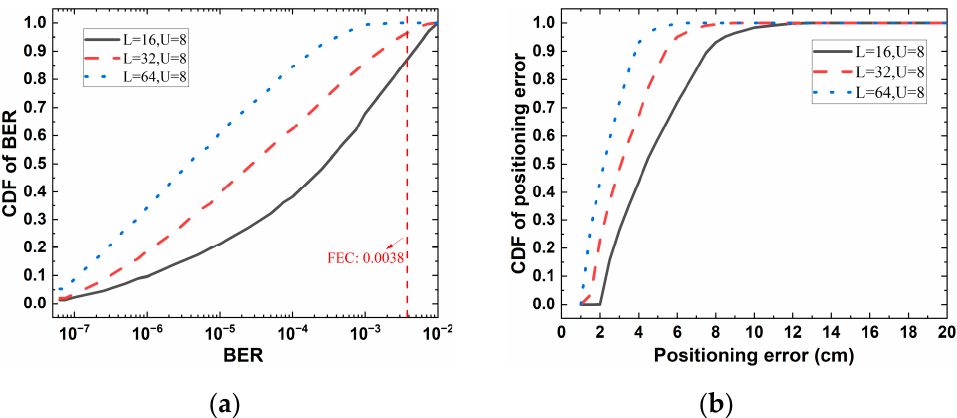
Figure 9. CDF of ( a ) BER and ( b ) positioning error estimated in the whole receiving plane when the 8-user VLCP system adopts spreading codes with different length.